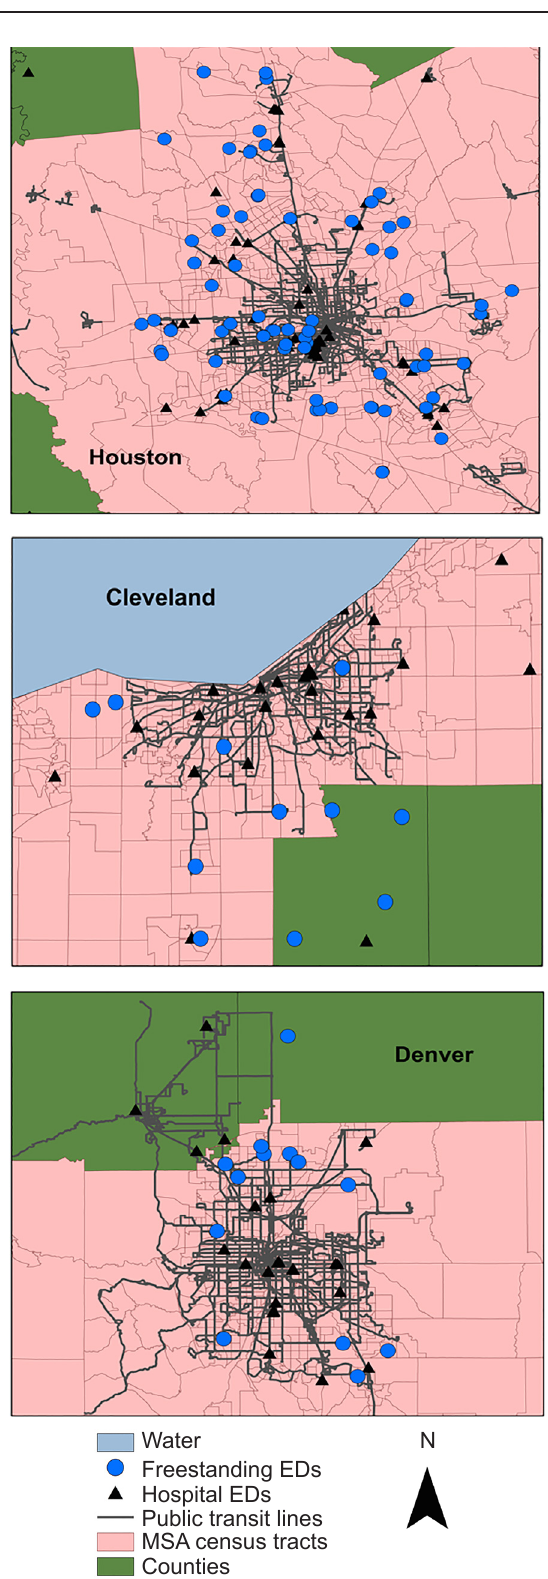
Figure. Freestanding emergency departments and